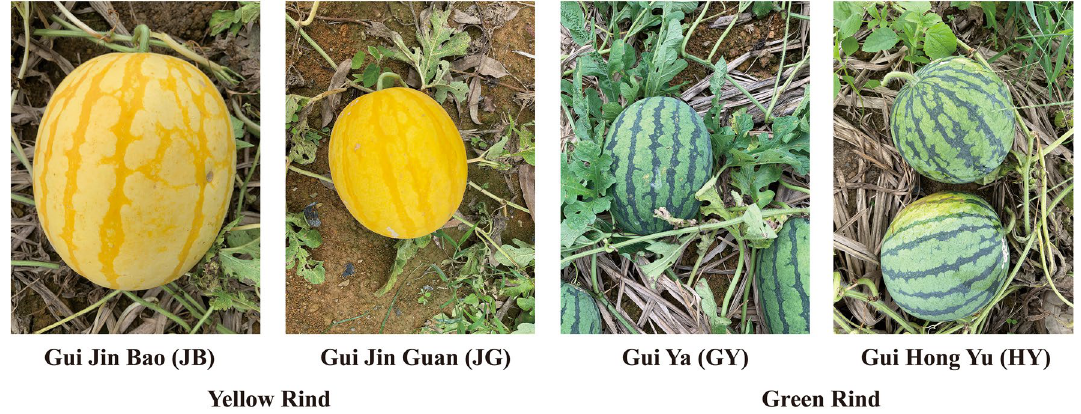
Figure 11. The appearance and morphological characteristics of different watermelon